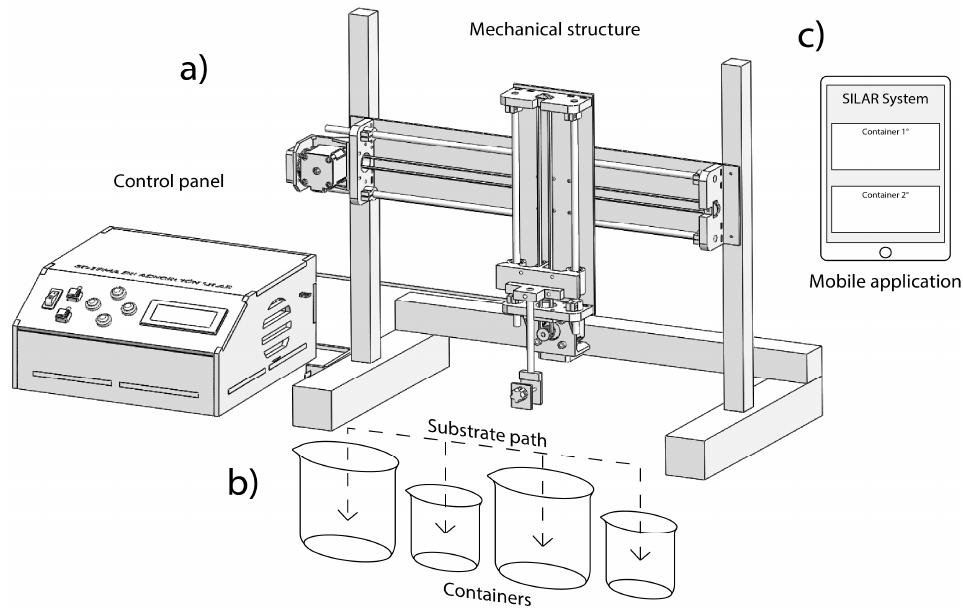
Figure 2. Automated SILAR device: ( a ) mechanical system and control panel, ( b ) displacement along horizontal and vertical axes, and ( c ) app installed in a mobile device.